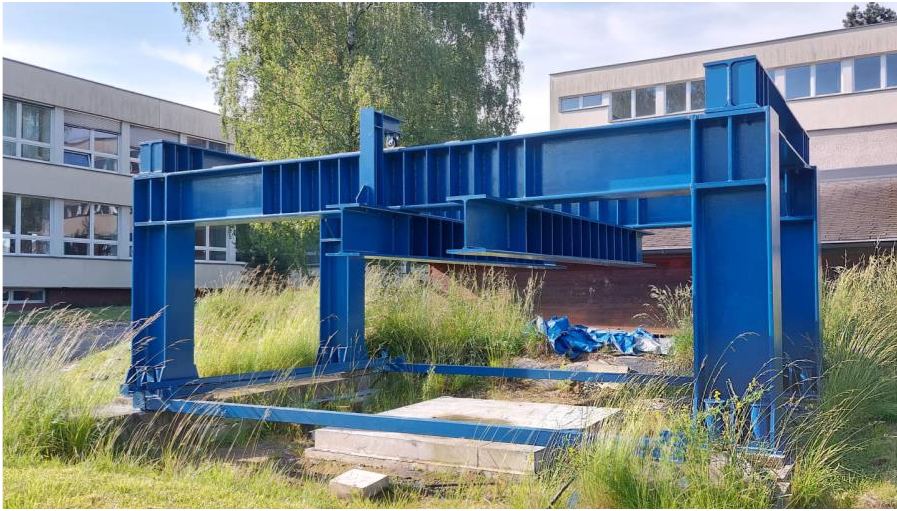
Figure 1. Experimental equipment on the campus of the FCE, VSB — Technical University of Ostrava.